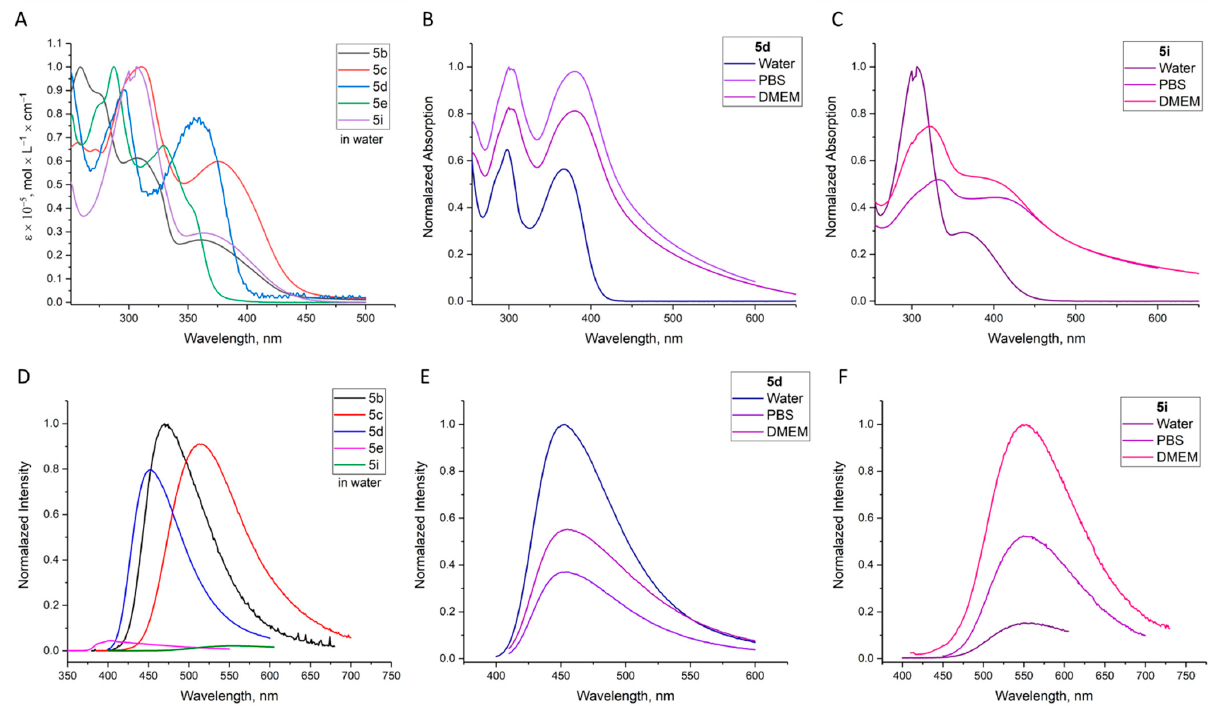
Figure 5. UV–Vis ( A – C ) and fluorescence spectra ( D – F ) of triazoles 5b – e,i in water/DMSO (0.5%, v / v ) ( A , D ); absorption and emission spectra for 5d in water/DMSO (0.5%, v / v ), PBS/DMSO (2%, v / v ), and DMEM/DMSO (2%, v / v ) ( B , E ); absorption and emission spectra for 5i in water/DMSO (0.5%, v / v ), PBS/DMSO (2%, v / v ), and DMEM/DMSO (2%, v / v ) ( C , F ).